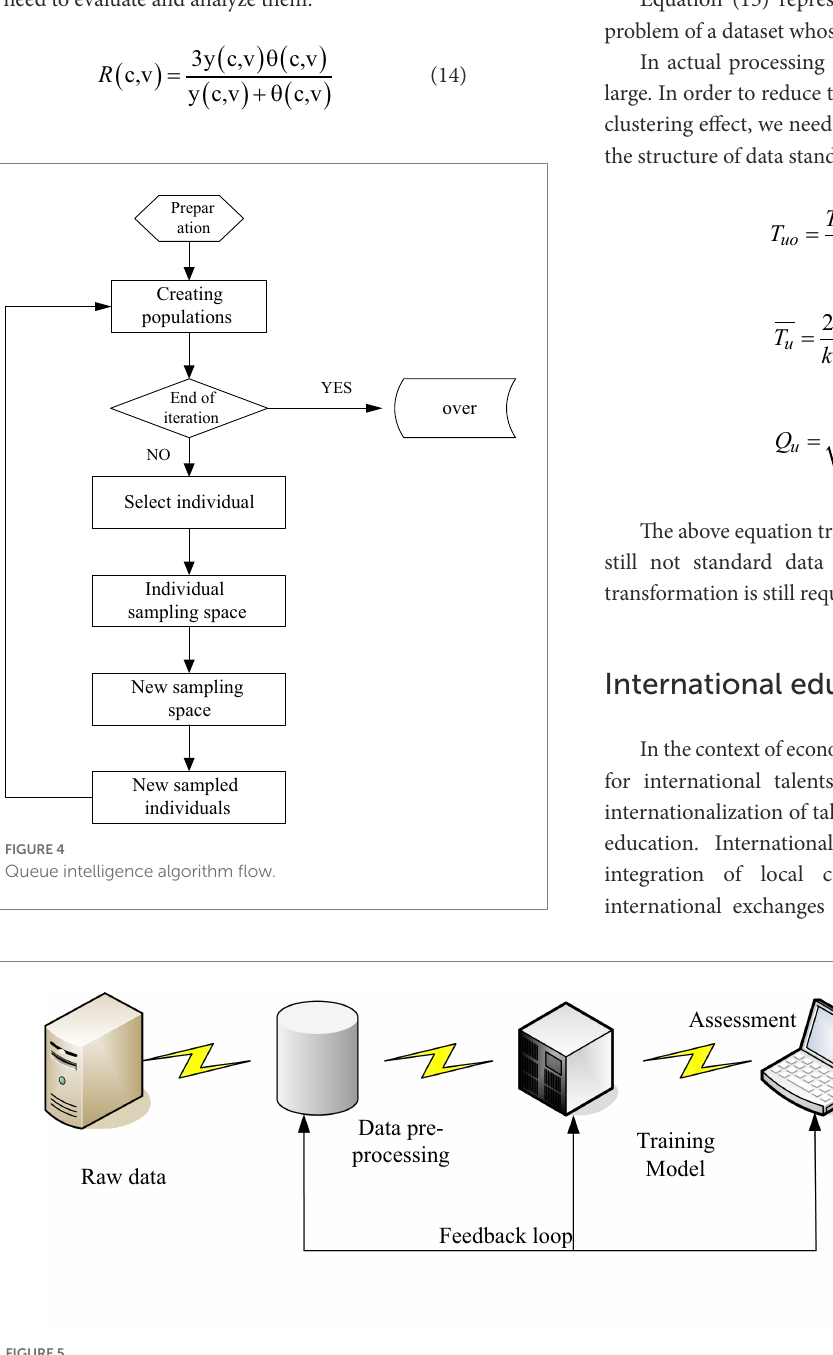
FIGURE 5 Data normalization processing structure.